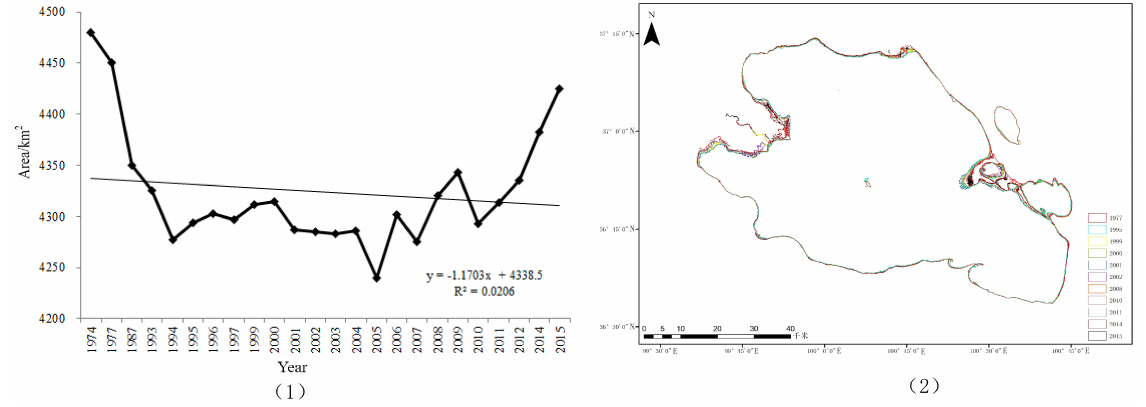
Figure 5. Dynamic map of Qinghai Lake area (1) Lake area trend map (2) Lake Boundary